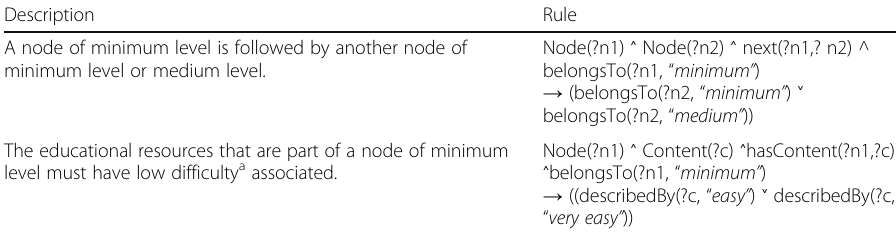
Table 1 Inference rules